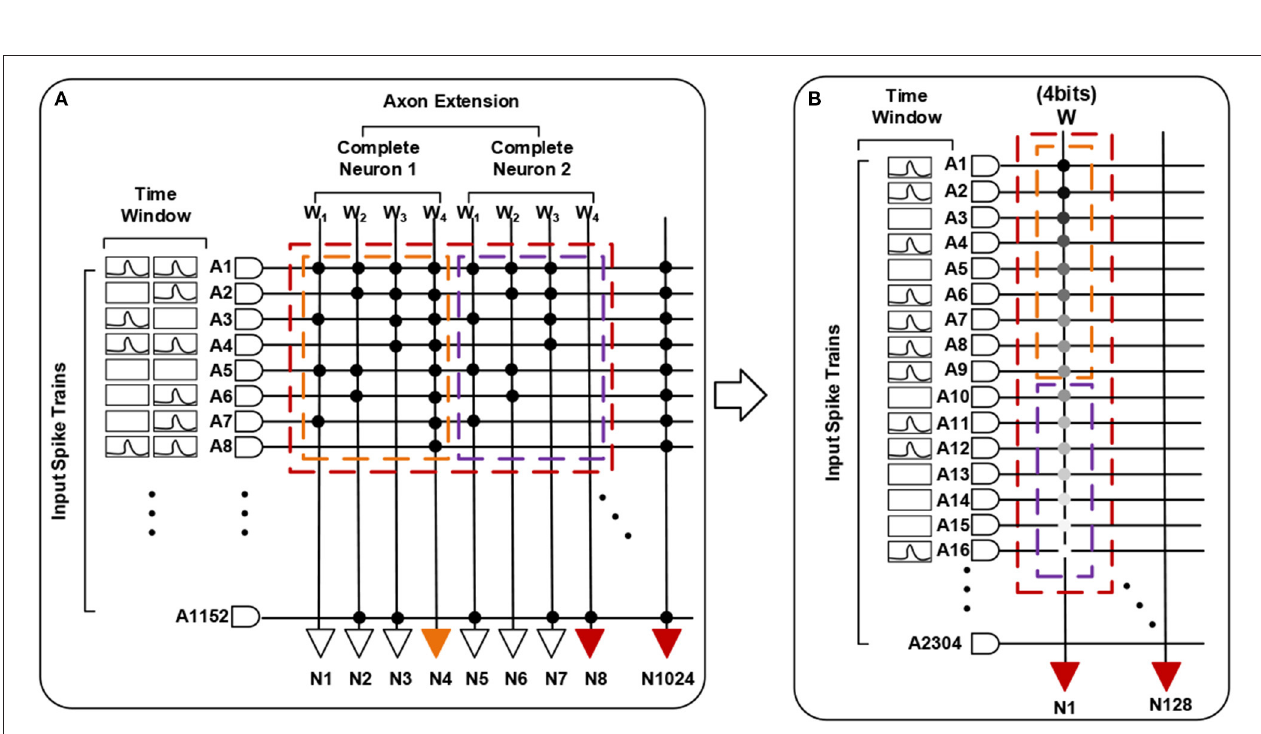
FIGURE 4 | A functional view of our neuromorphic chip. (A) describes a spatial neuron with axon extension f = 2 (two complete neurons) and a combination for 4-bit weights. (B) is the equivalent one.